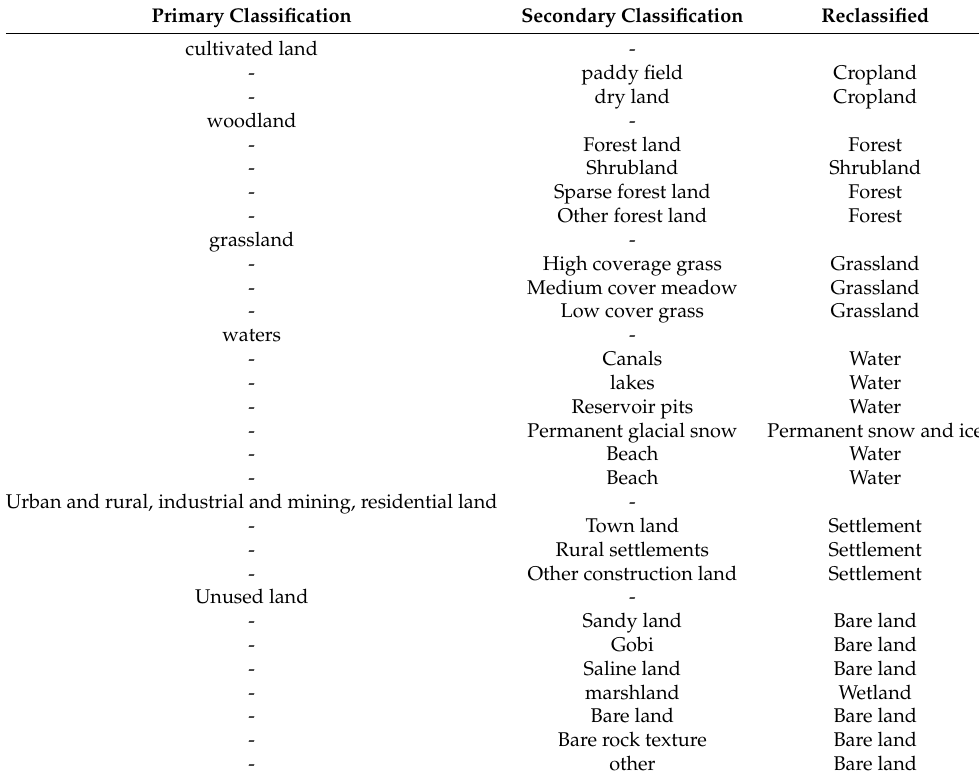
Table 2. Reclassification of 25 land classes in the Landuse dataset in China (1980–2015) into 10 land categories consistent with